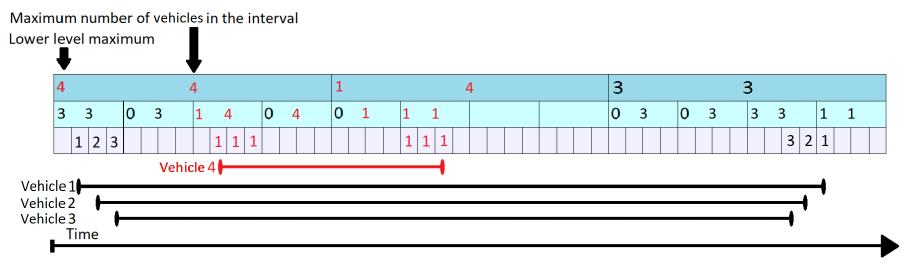
Figure 8. KI Tree Update for Vehicle